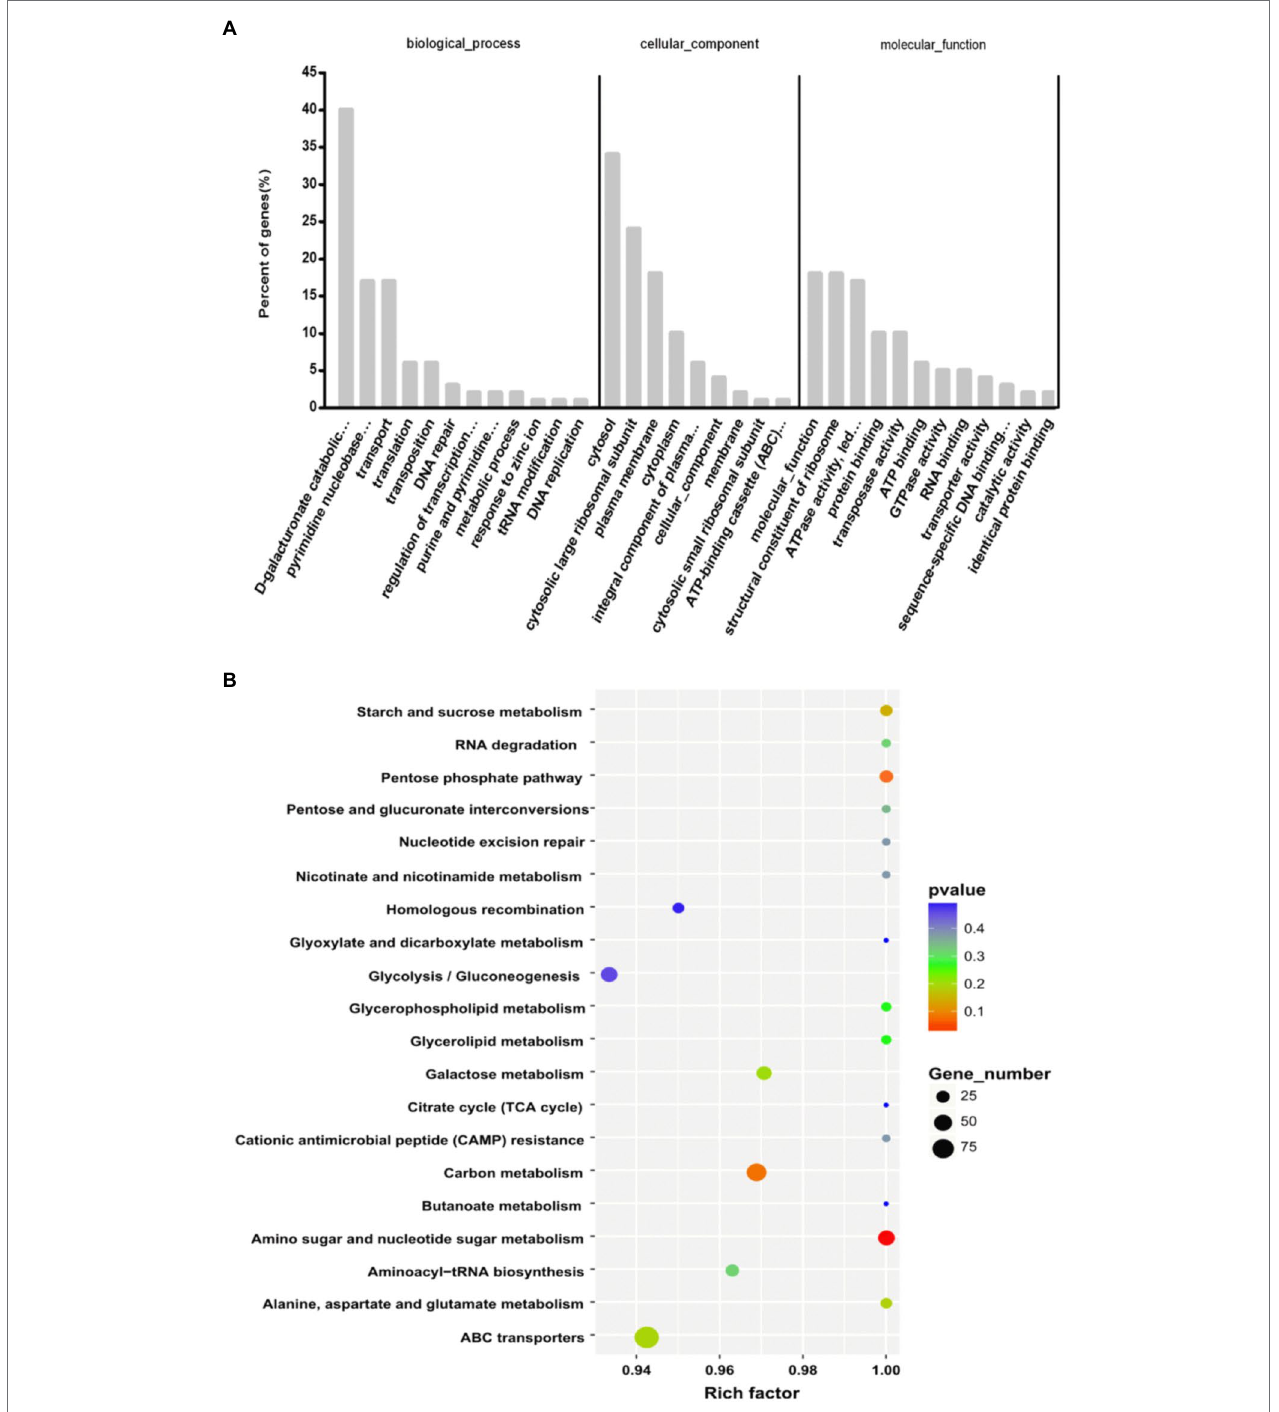
FIGURE 3 | Functional analyses of predicted target sRNA genes. (A) GO analysis of the target genes predicted to be involved in biological processes, molecular functions and their cellular components. (B) KEGG analysis of target genes participating in major